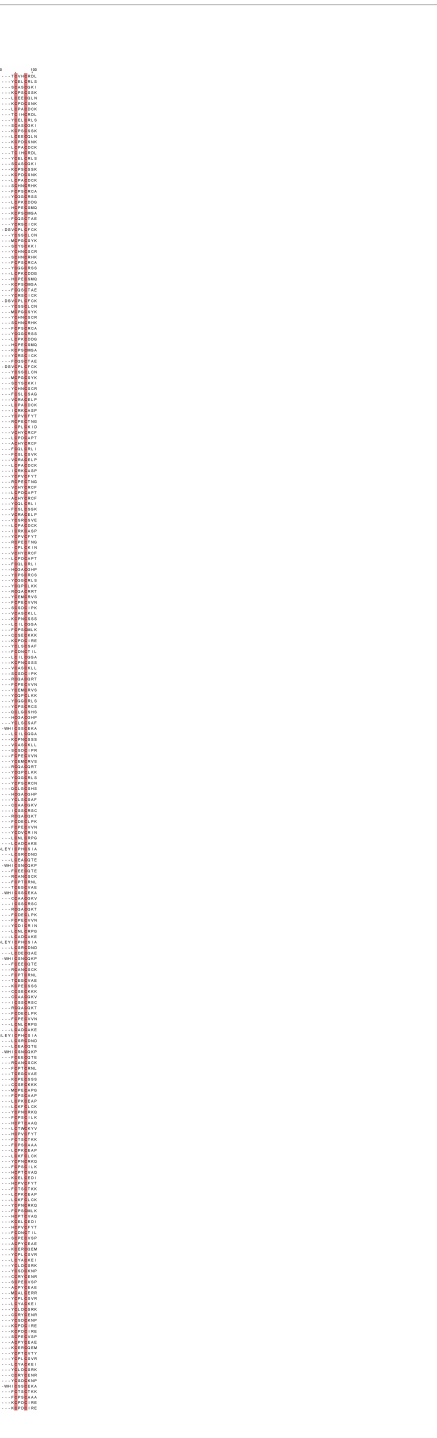
FIGURE 1 Protein sequence multiple alignment of the PHD- fi nger domains in TaPHD family proteins. The multiple alignment was conducted with the amino acid sequences within the predicted PHD domains by using Jalview software. The conserved amino acids (Cys4-His-Cys3) within the PHD- fi nger domains are shaded in red and